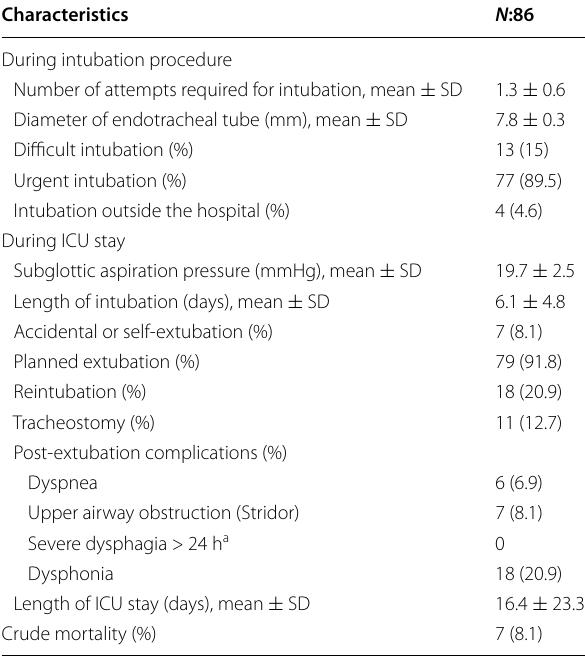
Table 2 Patient characteristics during intubation and dur-